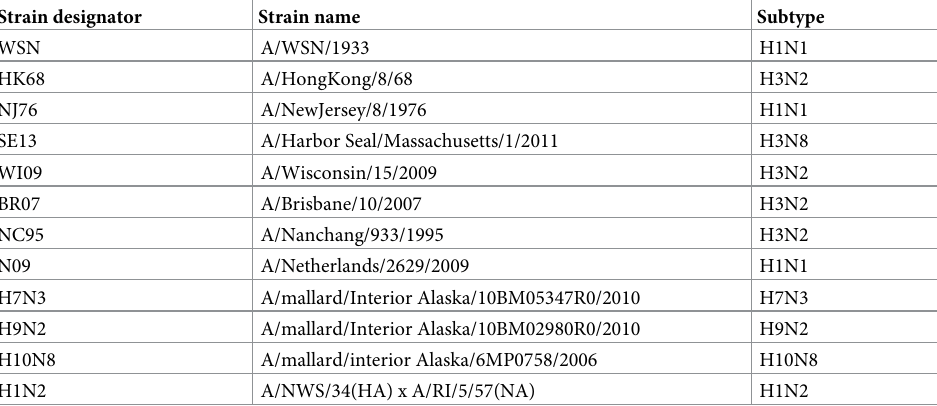
Table 3. Description of influenza virus strains